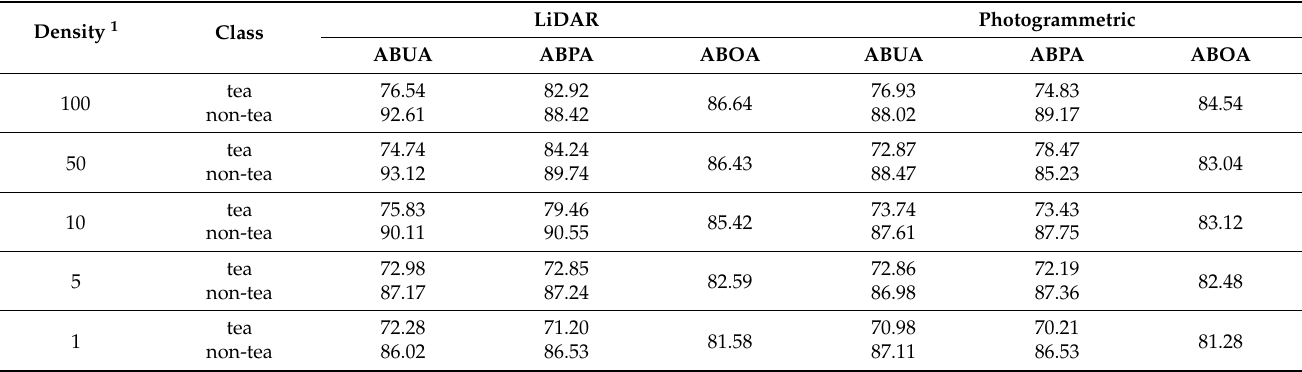
Table 10. Summary of the area-based descriptive statistics as percentages (%) using the ELM algo- rithm. ABUA: area-based user’s accuracy; ABPA: area-based producer’s accuracy; ABOA: area-based overall